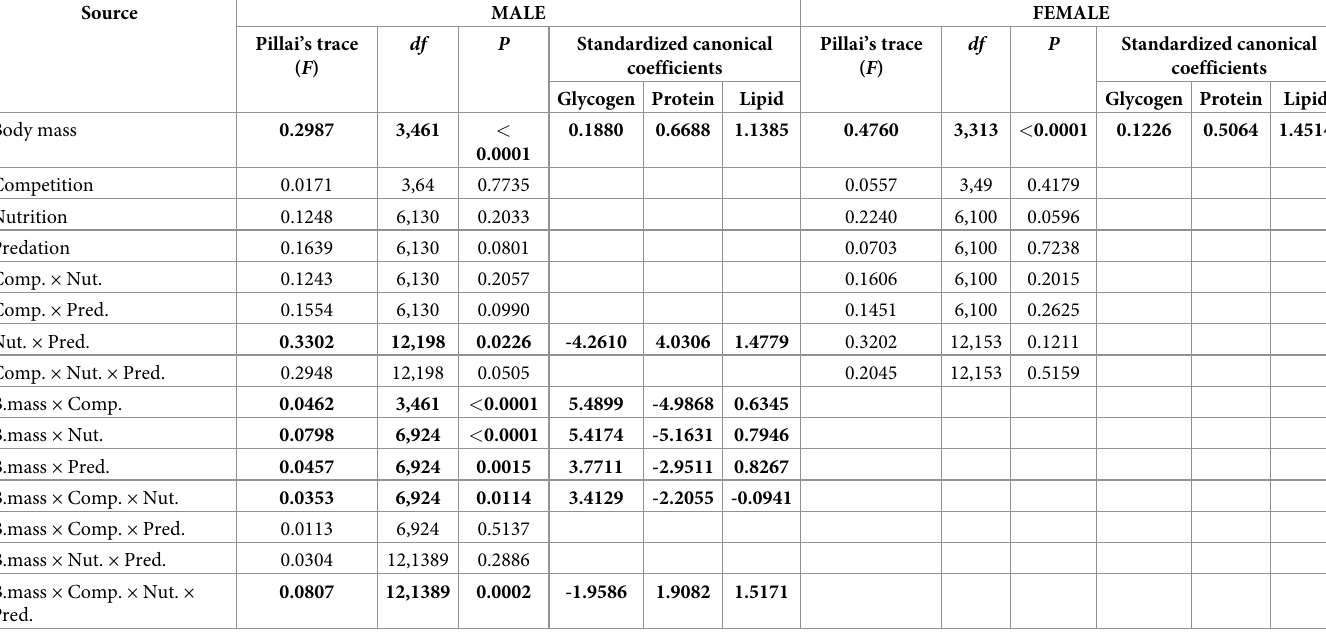
Table 3. Stored teneral